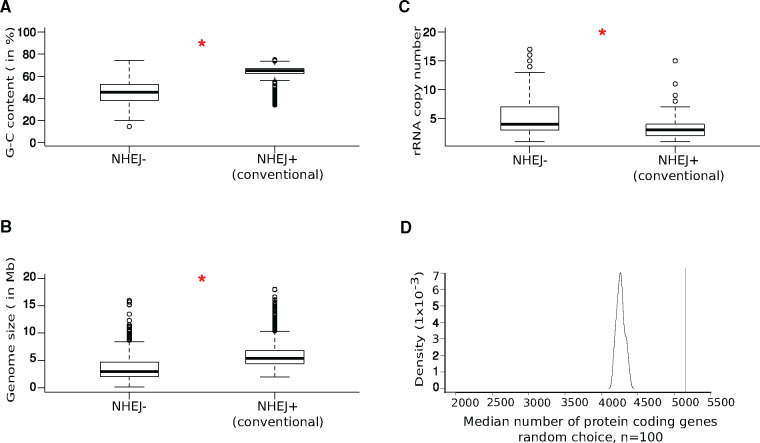
NHEJ presence and absence is associated with GS, GR, and G–C content. The red asterisk indicates statistical significance (Wilcoxon rank-sum test; P value < 0.01). (A) Boxplot comparing the distribution of G–C content between NHEJ– and conventional NHEJ+ bacteria. (B) Boxplot comparing the distribution of GS between NHEJ− and conventional NHEJ+ bacteria. (C) Boxplot comparing the distribution of rRNA copy number between NHEJ− and conventional NHEJ+ bacteria. (D) A density distribution plot depicting the distribution of GS (median number of protein coding sequences) expected by a random distribution (black) where the probability of having NHEJ is linearly proportional to GS and the median GS of organisms harboring NHEJ (red).